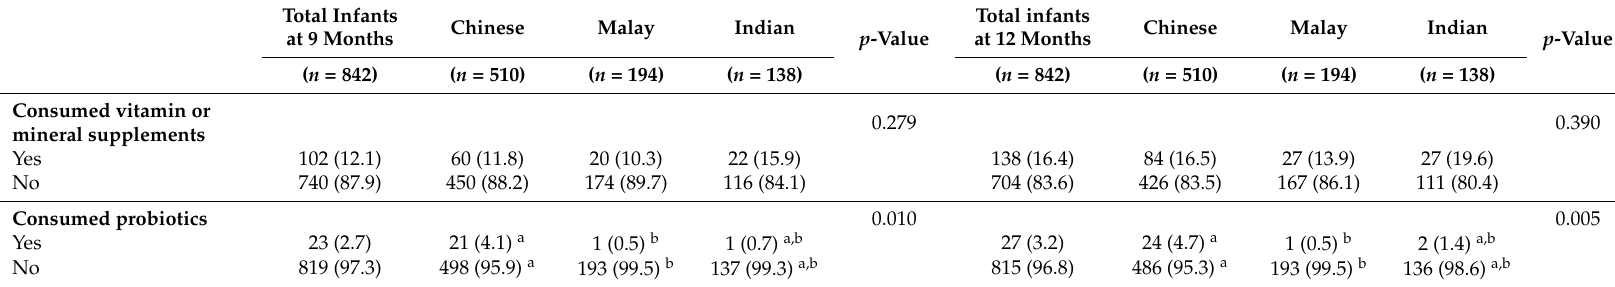
Table 2. Comparison of dietary supplementation and consumption of probiotics at 9 and 12 months among Chinese, Malay and Indian infants ( n (%)). Total Infants Chinese Malay at 9 Months Consumed vitamin or mineral